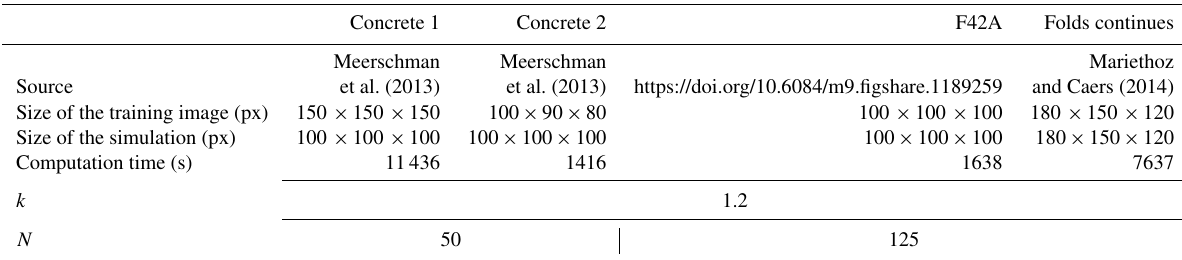
Table A4. Simulation parameters for Fig. A3. Times are specified for simulations without